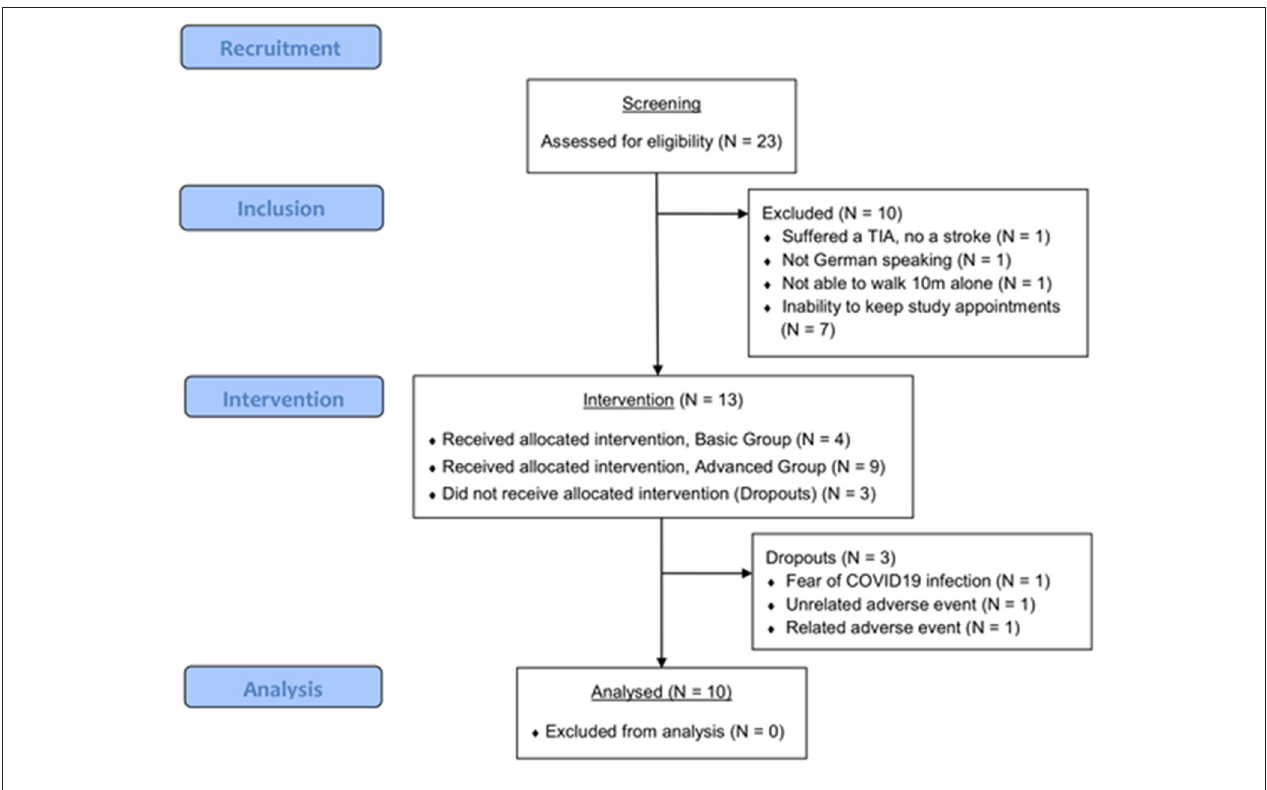
FIGURE 4 | CONSORT diagram of the participant flow.